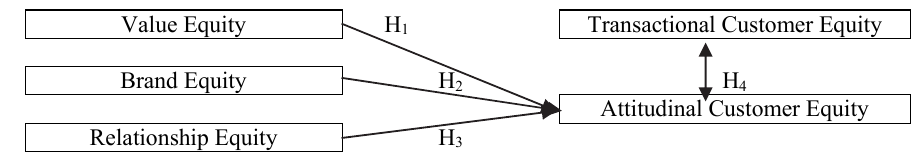
Fig. 1. The structure of the proposed